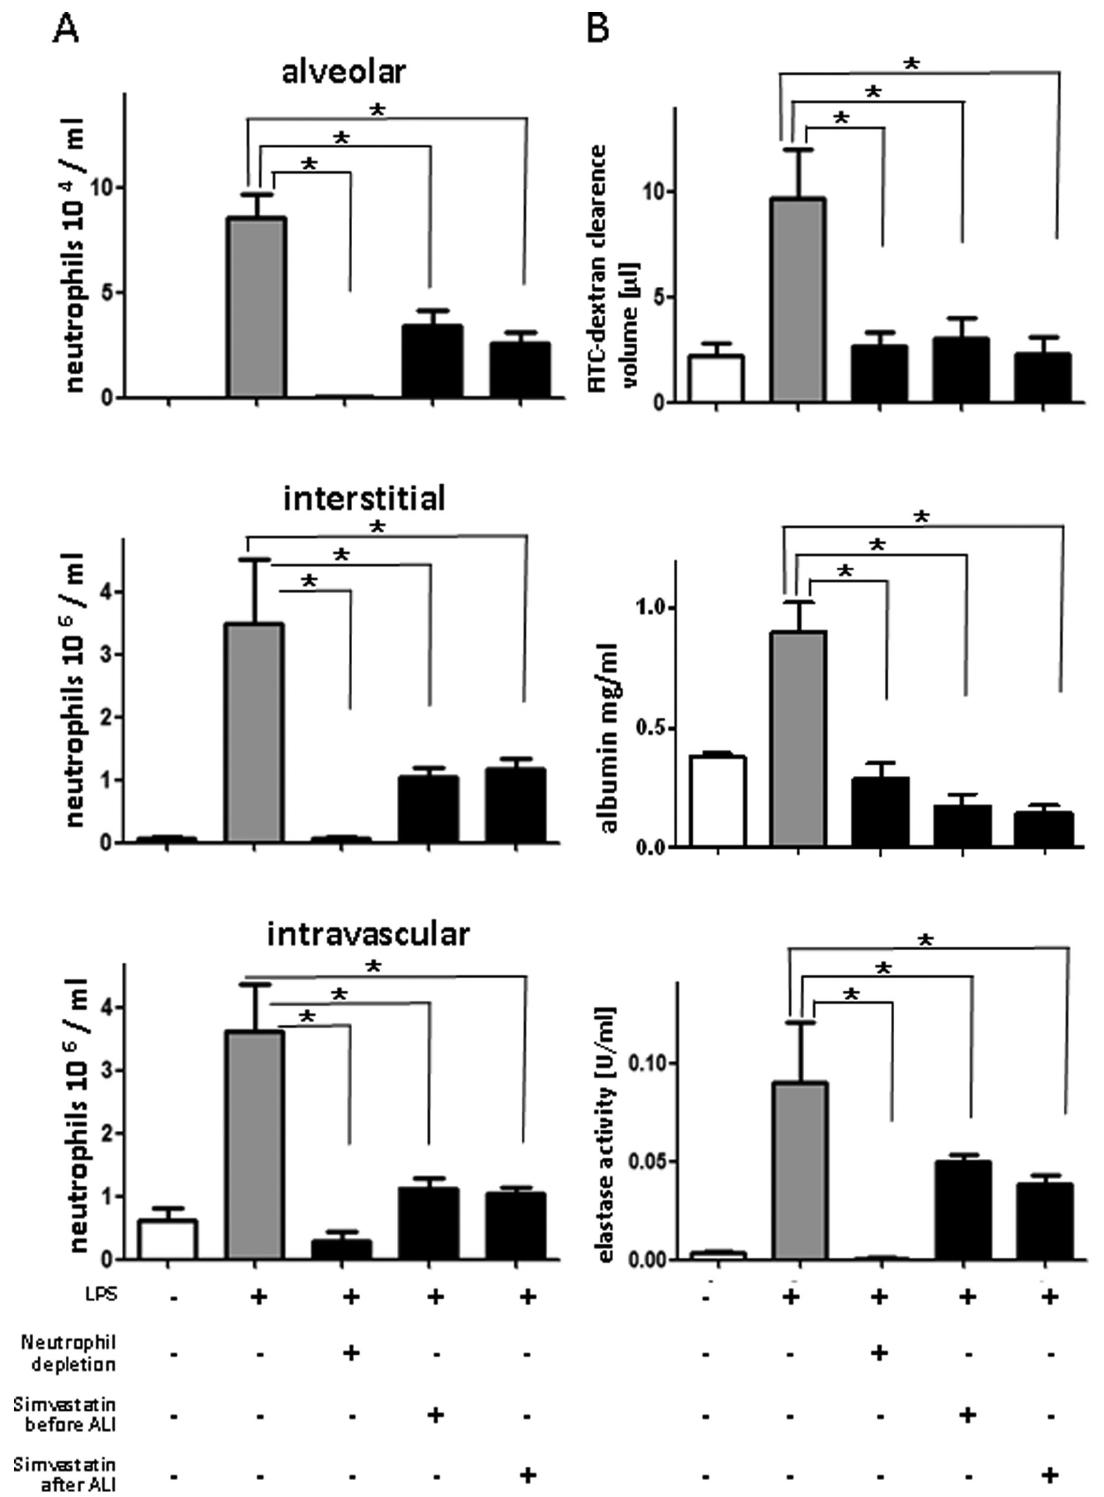
Figure 1. Simvastatin reduces LPS-induced acute lung injury by interference with neutrophil recruitment. Mice were challenged with LPS via inhalation and sacrificed 4 hours later. In addition, neutrophils were depleted by antibody injection or mice were treated with simvastatin (2 m g/g bodyweight) 12 hours and one hour before or one hour after LPS exposure as indicated. A: Quantification of alveolar (top), interstitial (middle), and intravascular neutrophils (bottom) in mice treated as indicated. B: FITC-dextran clearance (top), albumin concentration (middle), and elastase activity (bottom) in BAL fluids in mice treated as indicated (n=8–10 for each bar). Statistical significance was tested using one way ANOVA with Newman-Keuls Multiple Comparison test. * indicates significant difference compared to LPS-treated animals.